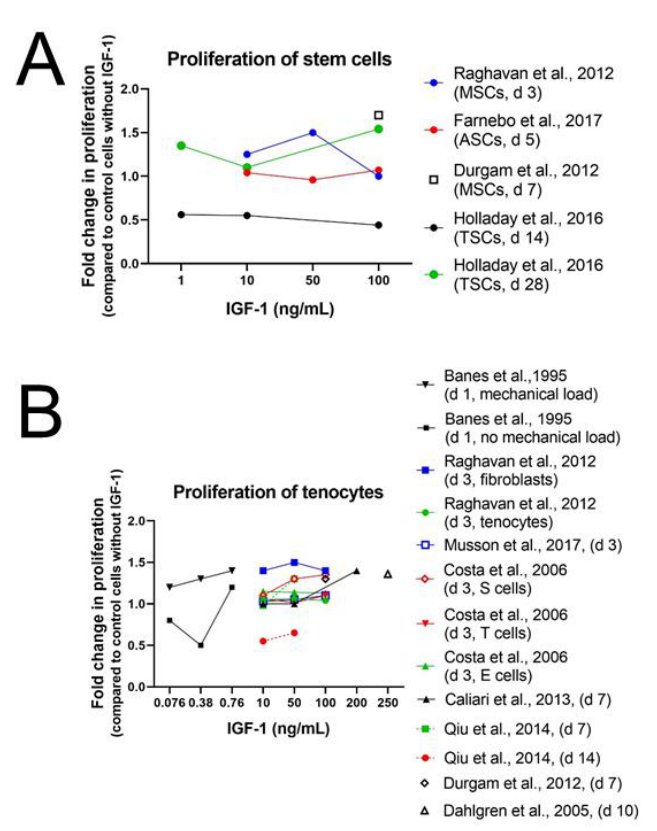
Figure 2. Human ASCs in Ham’s F12 containing 0.2% bovine serum albumin BSA [77]; rat ASCs in ECM-solution containing 10% FCS [79]; equine MSCs in high-glucose DMEM containing 10% FBS and AA (37.5 µ g/mL) [76] and rat TSCs in basal TSC medium [78] ( A ). Avian tenocytes in DMEM without FCS [13]; human tenocytes in Ham’s F12 containing 0.2% BSA [77]; rat tenocytes in DMEM/F12 containing 0.5% FBS [80]; rabbit tenocytes in Hams’s F12 containing 0.2% BSA [81]; equine tenocytes in DMEM without FCS [82]; human tenocytes in α -MEM without FBS [83]; equine tenocytes in high-glucose DMEM containing 10% FBS and ascorbic acid (AA) (37.5 µ g/mL) [76]; M-199 medium containing 5% FBS and AA (100 µ g/mL) [84] ( B ). For better view, see also SI Figure S1.